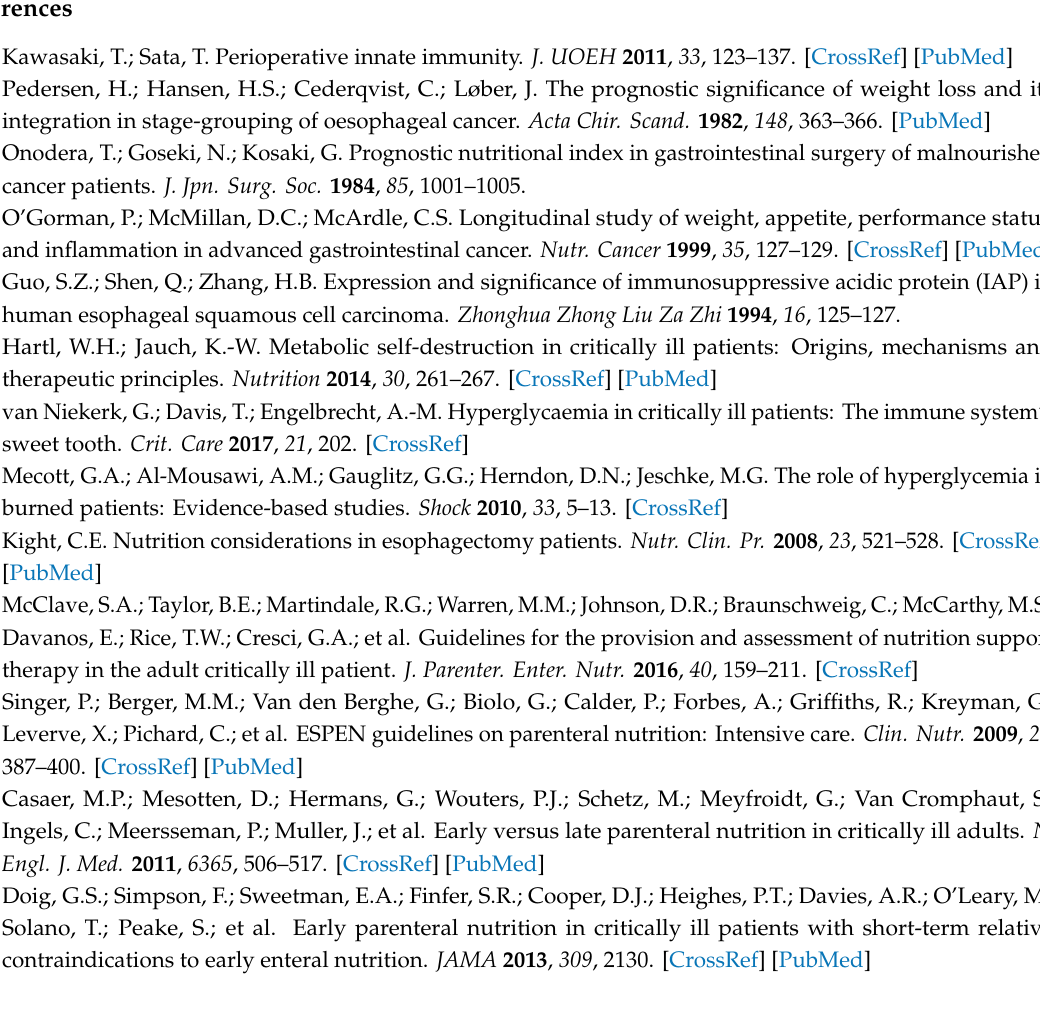
Table S1: Equations of BEE, PNI, and NRI, Table S2: Equations of